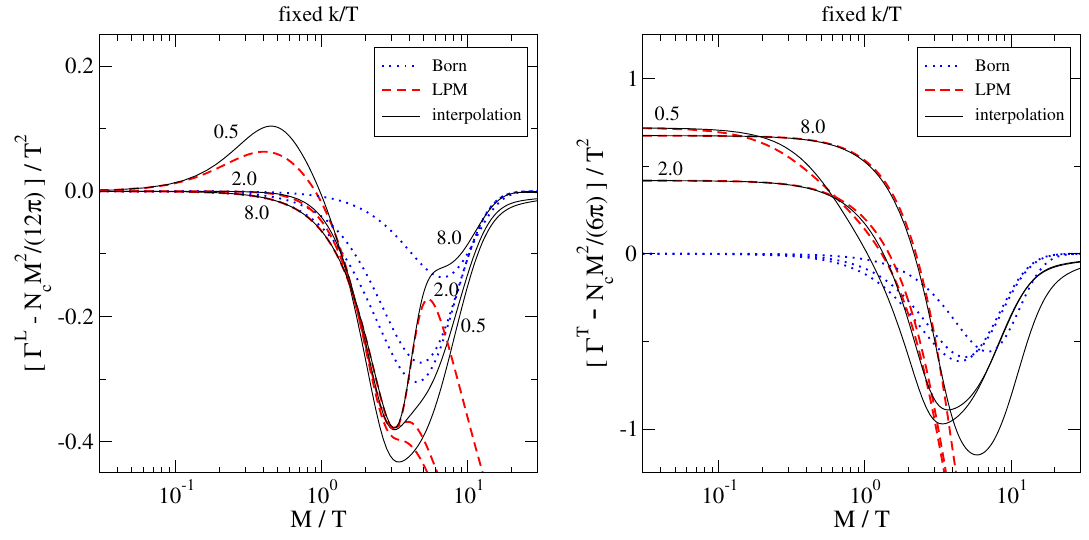
Figure 3 . Results for the dilepton interaction rates in the L (left) and T (right) channels, after the subtraction of the leading-order vacuum contributions, cf. eq. (5.2). The value of k/T has been indicated next to the